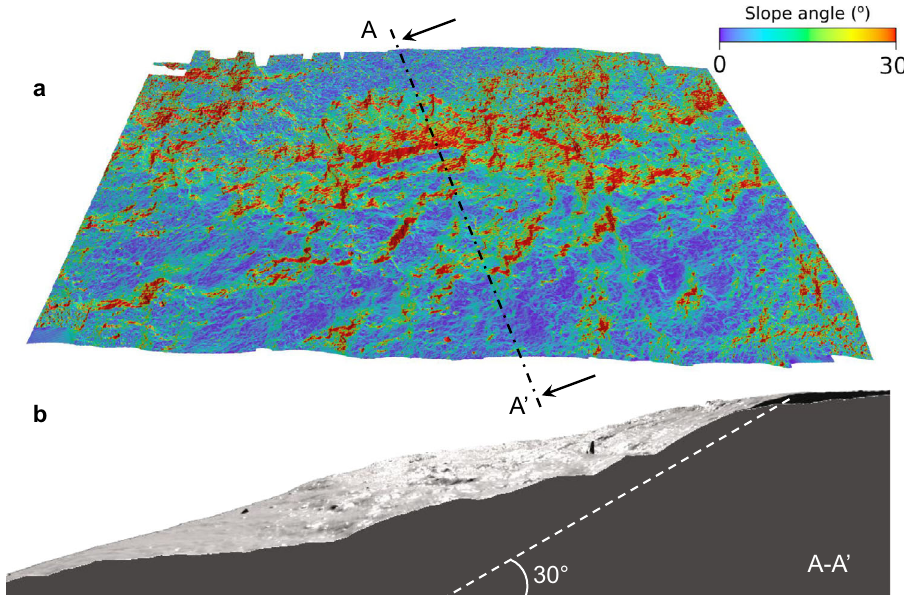
Fig. 2 Local topography. a Digital Elevation Model (DEM) showing the local slope angle. The DEM was obtained based on a drone photogrammetry analysis (summer 2021 survey) and has a resolution of 9cm. b A – A ′ section showing that although the average slope angle is around 20°, locally steeper steps have indeed an inclination exceeding 30° (given as an indicator by white dashed